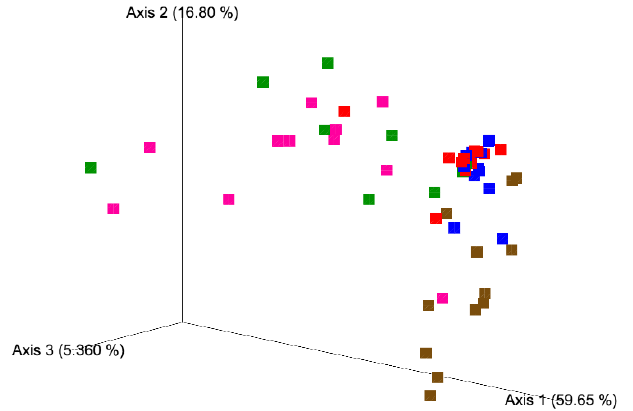
Figure 3. Principal coordinate analysis (PCoA) based on weighted unifrac distance matrix of milk (brown), natural milk cultures (NMC, magenta), curd (green), 5-day ripened cheese (blue), and 15-day ripened cheeses (red).